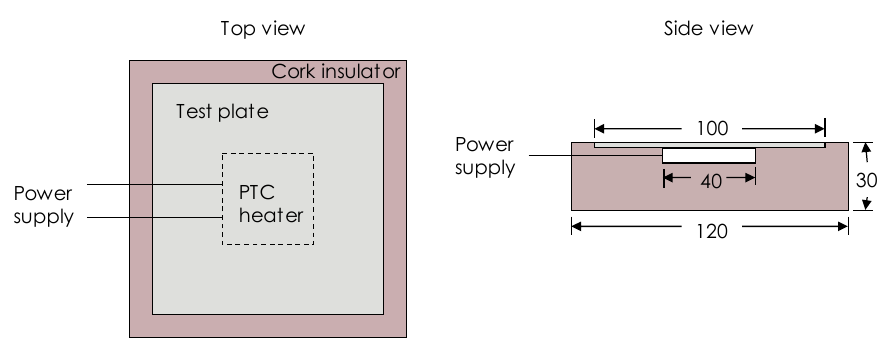
Figure 2. The experimental setup for conducting natural convection.